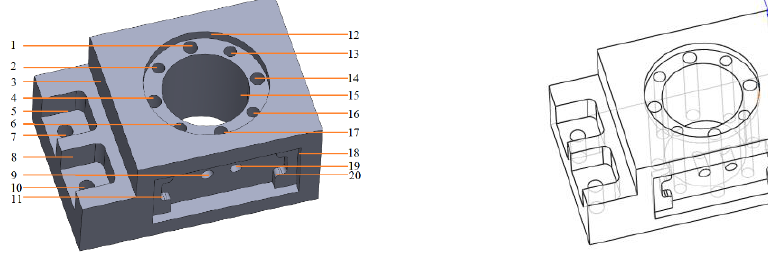
Figure 7. Part features recognized in Zhang’s article (1–20 are Figure 8. Part features recognized in Zhang ’ s article(1 – 20 are features).